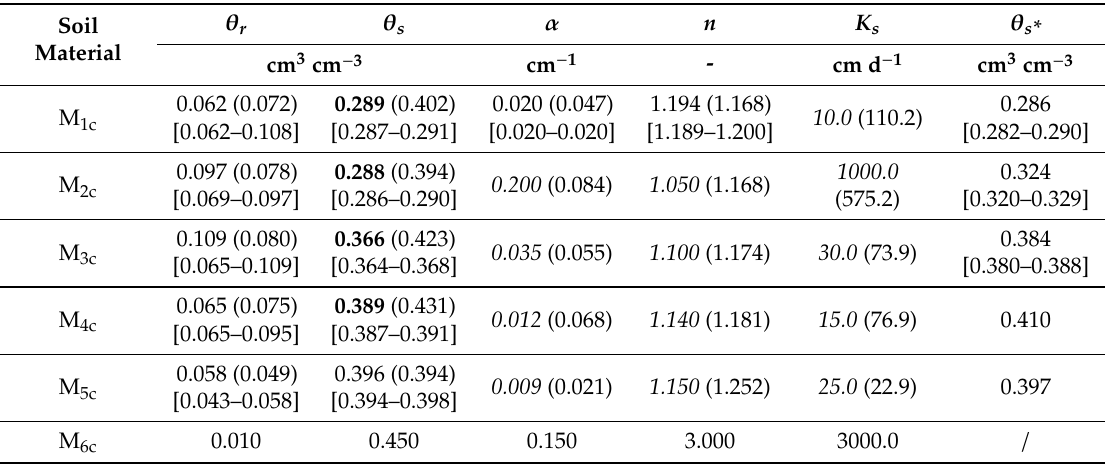
Table 7. Parameters optimized using HYDRUS-1D for each of the six soil materials of Lys. 1. Soil Material